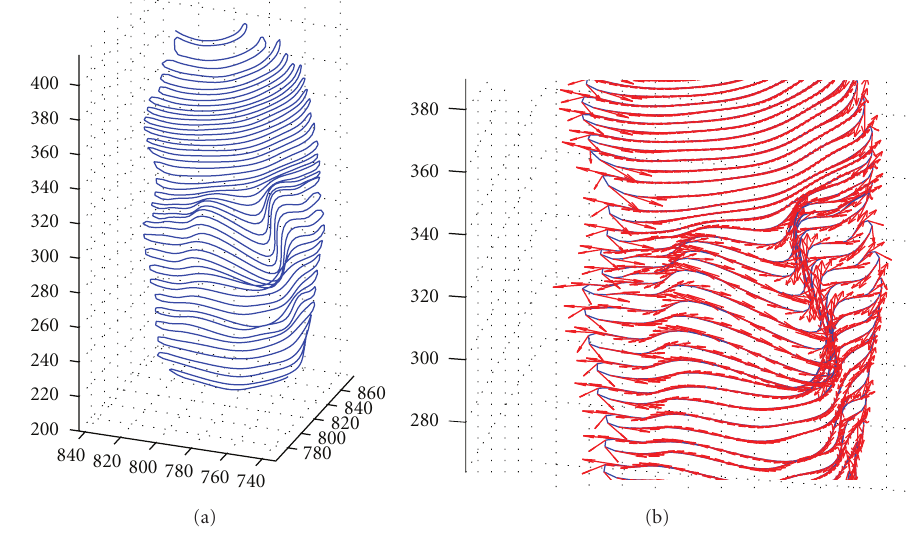
Figure 14: Trajectory and speed vector in its point.